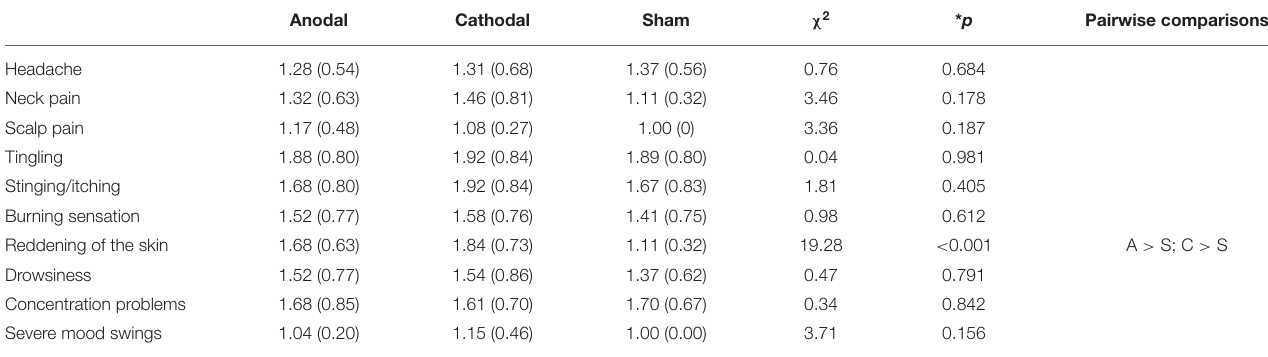
TABLE 1 | Descriptive statistics (mean and standard deviations) of the responses to the questionnaire on tDCS adverse effects. Anodal